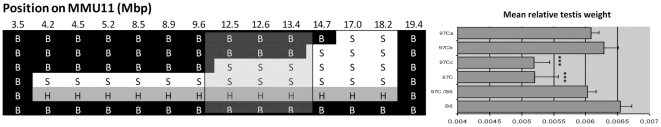
Fine mapping of the low testis weight QTL in inter-recombinant strains generated for this study from 97Crc11.Left panel: genotypes of the different recombinant lines (97Crc11a, b, c, noted 97Ca, b and c in the figure), parent B6, 97 C and heterozygote 97 C/B6. Black regions correspond to B6 background, white regions to homozygous spretus fragments and grey regions to heterozygous spretus fragments on chromosome 11. Marker positions are given in megabase pairs. Right panel: Histogram of the testis weight relative to body weight expressed as mean ± SEM for a minimum of 5 animals. *** denotes a significant difference when compared to B6 (p<10−3). By analyzing the fragment/phenotype segregation, it could be concluded that since 97 C and 97Crc11c exhibit the phenotype of low testis weight, the Ltw1 QTL is located in a fragment of 5 Mb or less on MMU11 (hachured region between 9.6 Mb to 14.7 Mb).